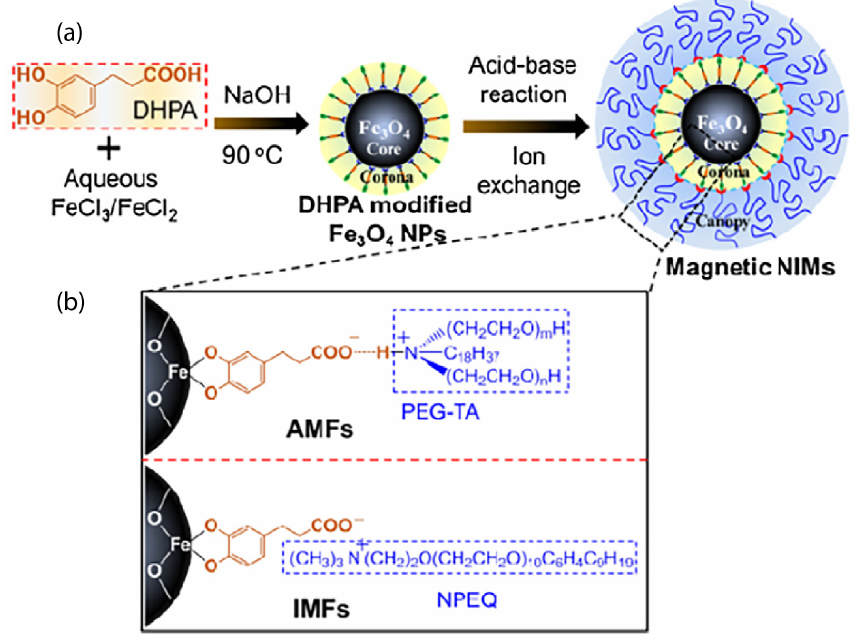
Figure 5. ( a ) Schematic showing the fabrication of Fe 3 O 4 hybrids, ( b ) the triple structures of the two types of hybrids of Fe 3 O 4 nanoparticle cores linked with PEG-TA canopy (denoted as AFMs) and NPEQ canopy (denoted as IMFs), respectively, by DHPA corona. Reprinted with permission from Li et al.